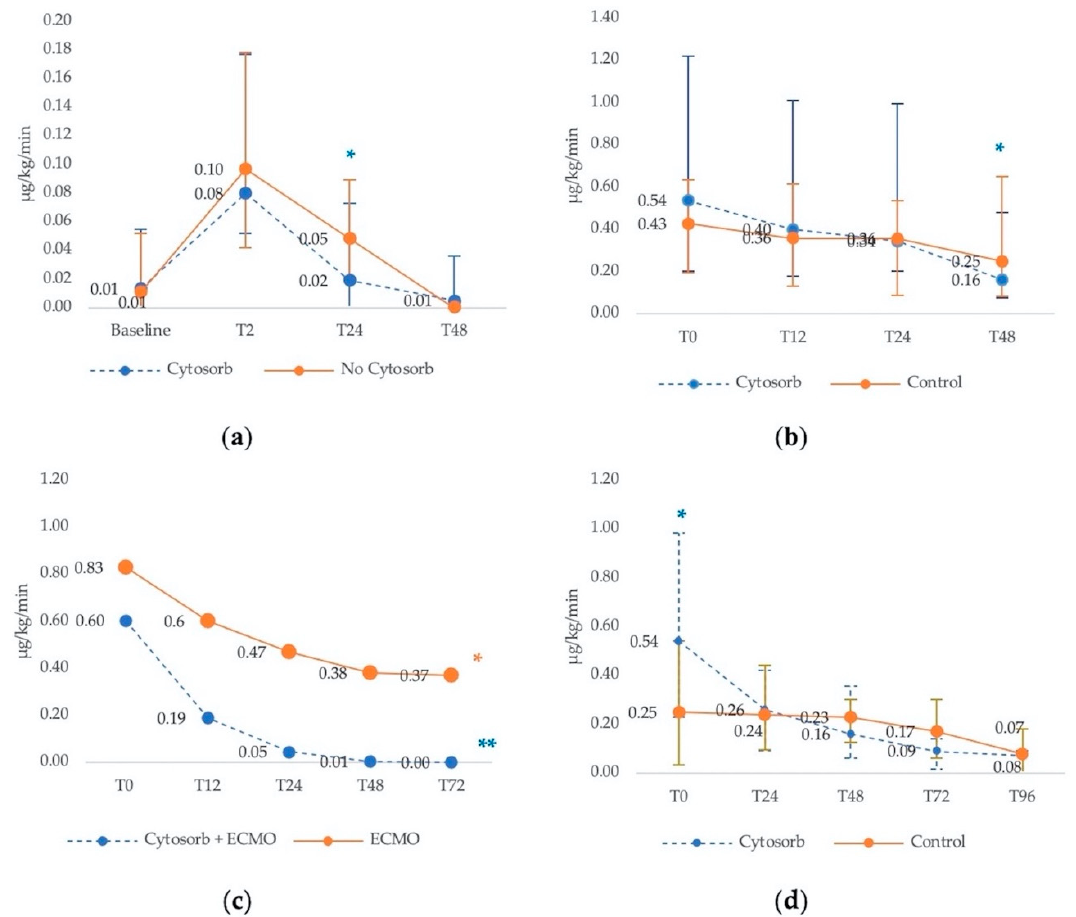
Figure 3. Median vasopressor therapy requirements in Cytosorb and control cohorts. ( a ) Median vasopressor therapy requirements in aortic surgery patients. Based on Mehta et al. [77]. * p < 0.05 for NE dose of Cytosorb vs. no Cytosorb at T24. ( b ) Median vasopressor therapy requirements in septic patients. Based on Hawchar et al. [64]. T 0 is measured right after inclusion (control) or start of hemoadsorption. T 12 , T 24 and T 48 were measured 12, 24 and 48 h later. * p < 0.05 vs. T 0 in the Cytosorb group. ( c ) Mean vasopressor therapy requirements in patient with pneumonia-derived sepsis. Based on Akil et al. [29]. Timepoints represent hours after the initial dose administered at the entrance into the ICU. * p = 0.05 at T 48 and T 72 in the ECMO group. ** p < 0.005 at T 12 , T 24 , T 48 and T 72 in the Cytosorb group. ( d ) Median vasopressor therapy requirements in septic shock patients requiring CRRT. Based on Rugg et al. [79]. Baseline is defined as the day of Cytosorb mounting in the treatment group. Data are presented as median and interquartile ranges. * p =0.014 as compared to baseline. For explanation see text.